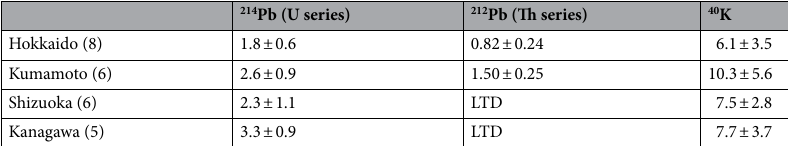
Table 1. Radioactivity of natural radionuclides (mBq/g) in deciduous teeth. Data are shown as mean ± counting error. Parentheses show numbers of teeth in a sample. Nuclides were measured in teeth for 1 million seconds (11.6 days). When the counts did not exceed the mean + 3SD of the background, we considered the value as LTD (lower than detection limit). SD, standard deviation.